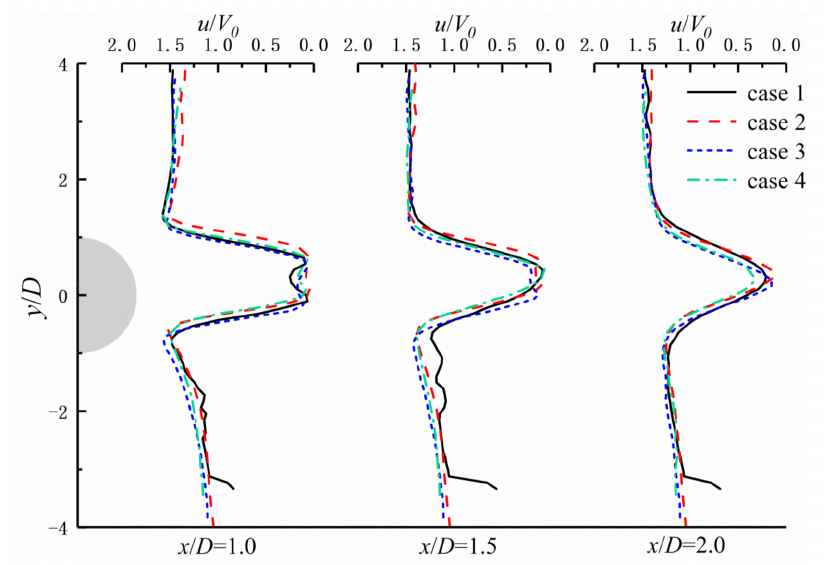
Figure 7. The distribution of the streamwise velocity for the smooth cylinder and the dimpled cylinder with different